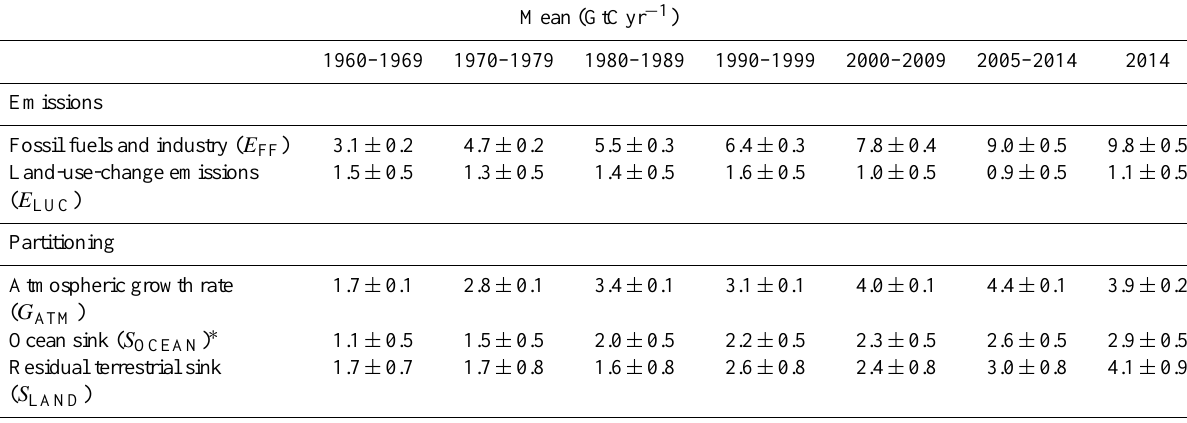
Table 8. Decadal mean in the five components of the anthropogenic CO 2 budget for the periods 1960–1969, 1970–1979, 1980–1989, 1990– 1999, 2000–2009, the last decade, and the last year available. All values are in GtCyr − 1 . All uncertainties are reported as ± 1 σ . A data set containing data for each year during 1959–2014 is available at http://cdiac.ornl.gov/GCP/carbonbudget/2015/. Please follow the terms of use and cite the original data sources as specified on the data